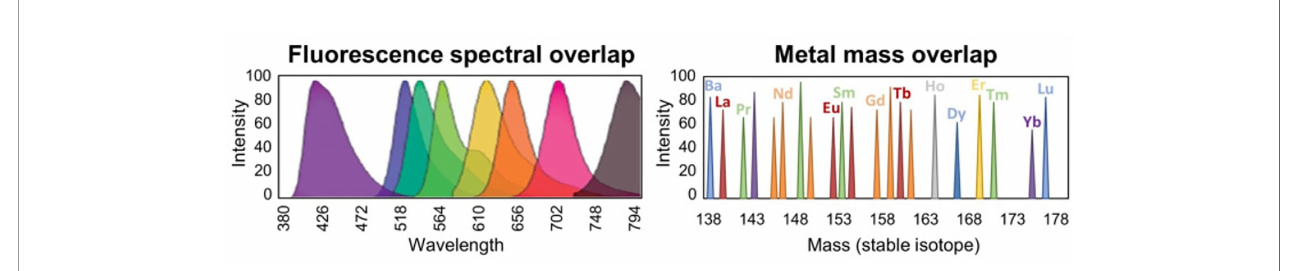
FIGURE 1 | Overcoming spectral overlap via mass cytometry. Signi fi cant spectral overlap complicates measurement of speci fi c parameters when detecting emitted light from fl uorophores in fl ow cytometry (left). Contamination of adjacent parameters is minimized via detection of heavy metal isotopes by mass cytometry (right). Figure adapted from (3).